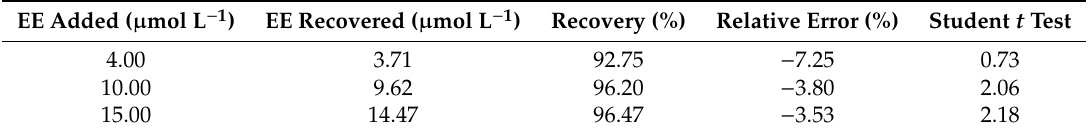
Table 11. Determination of ethinyl estradiol in river water using the proposed method.